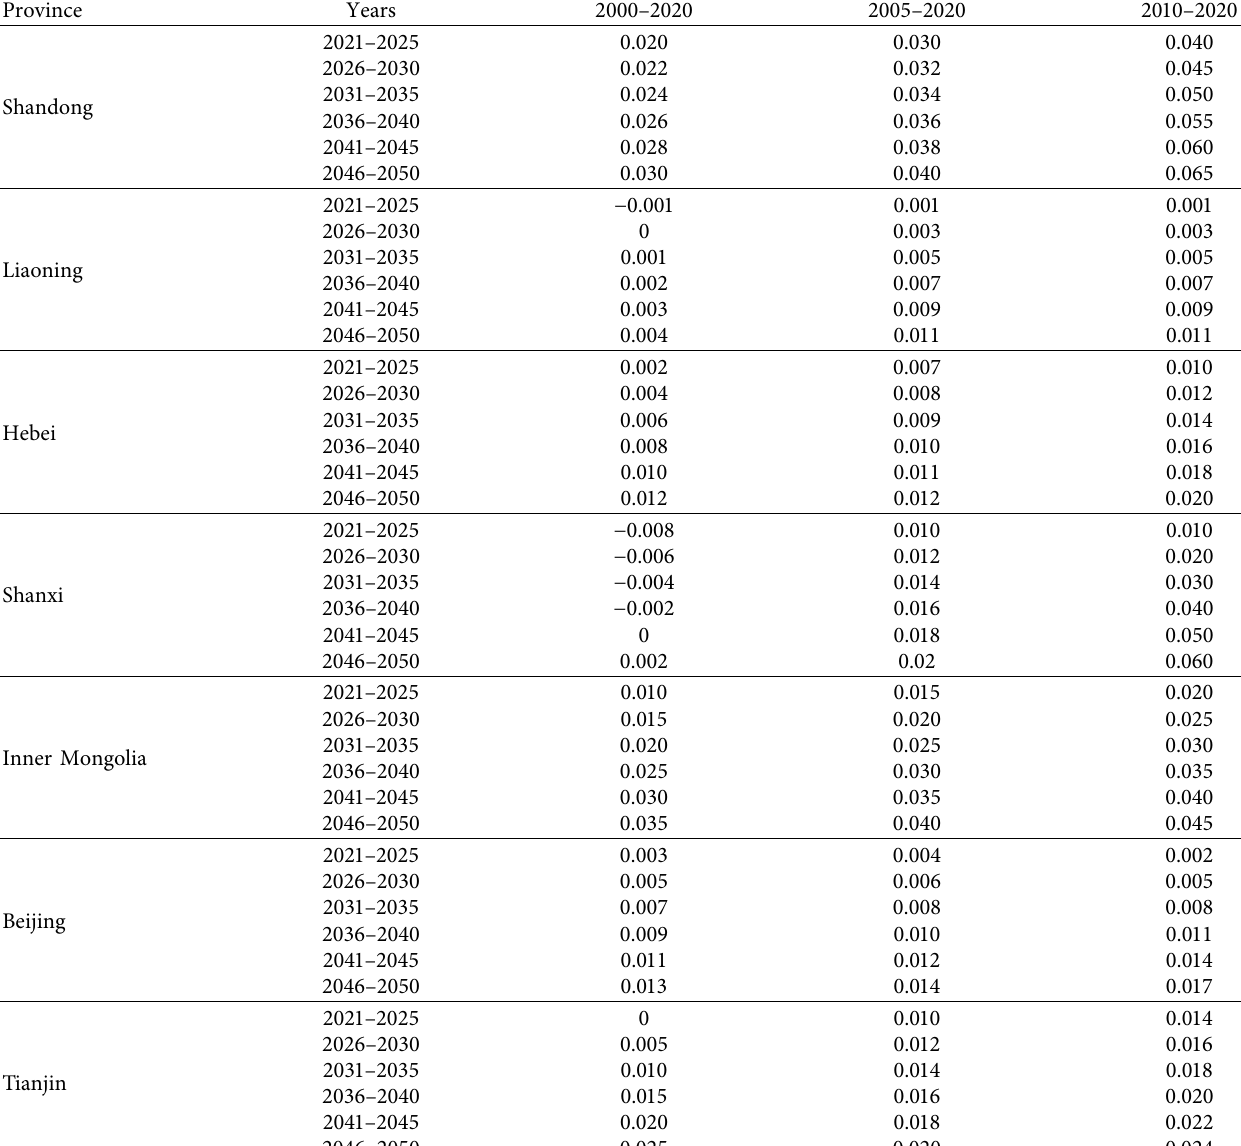
Table 5: Prediction of β parameter under three